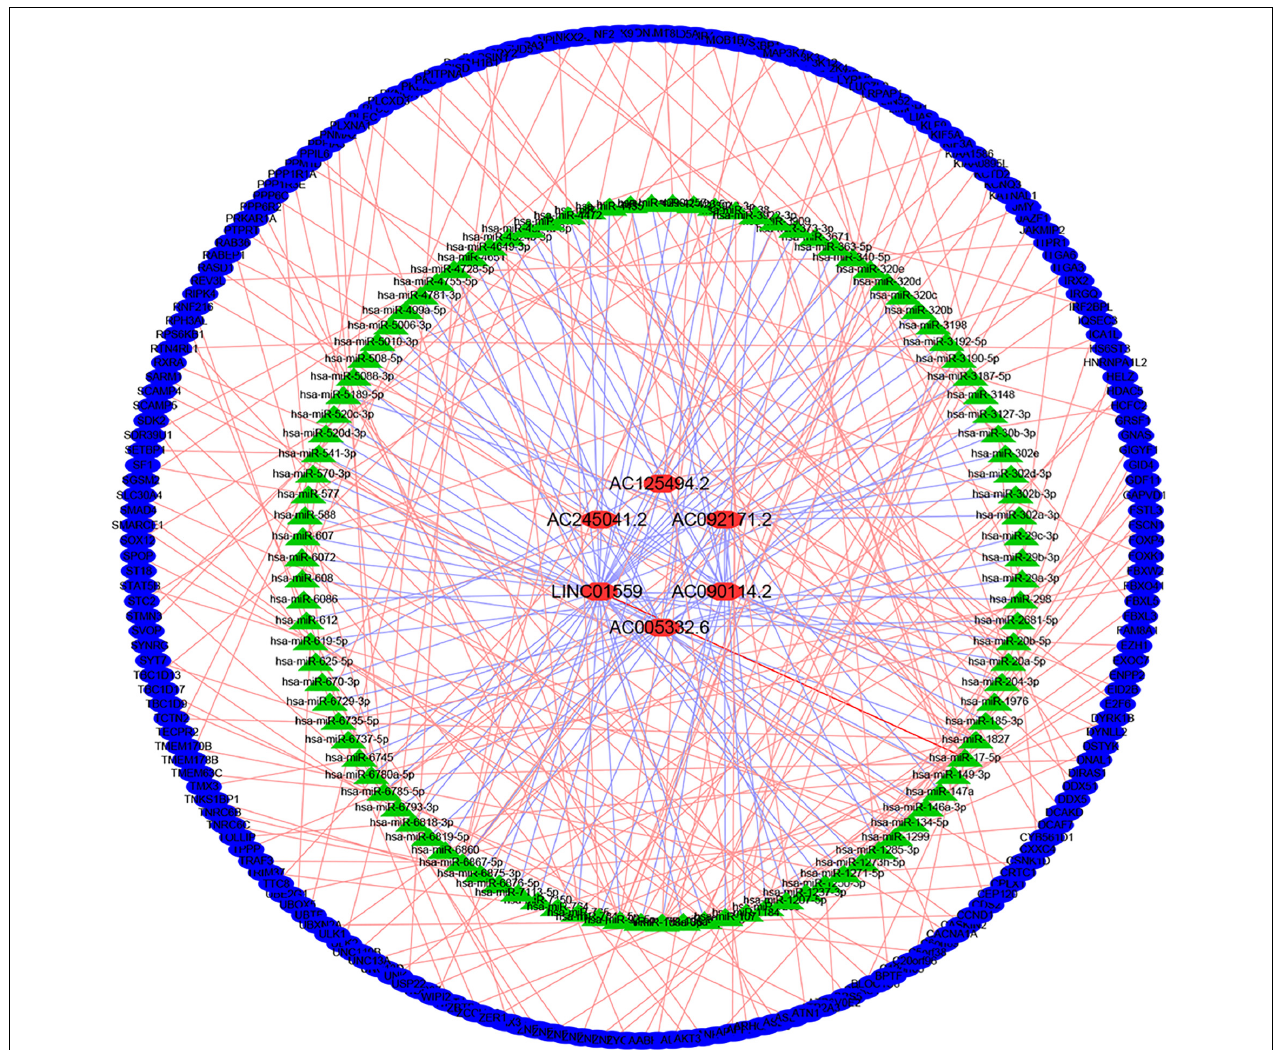
FIGURE 6 | Construction of lncRNA-miRNA-mRNA regulatory networks.